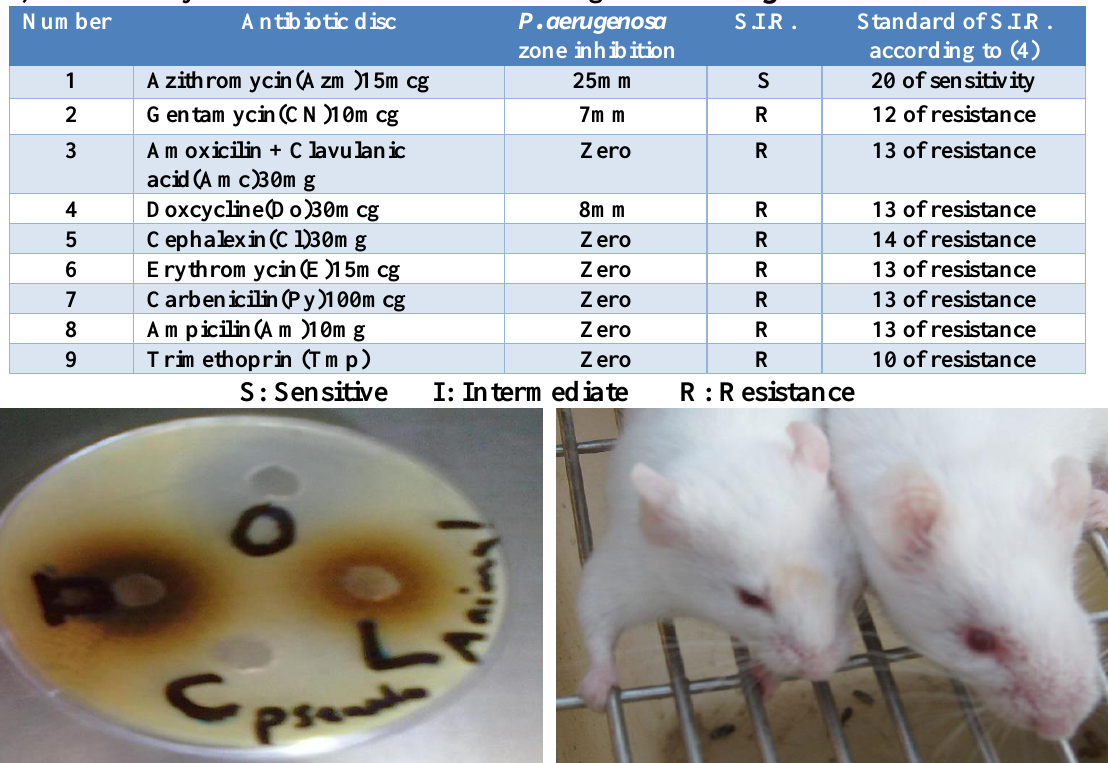
Figure, 2: Show swallowing of face and